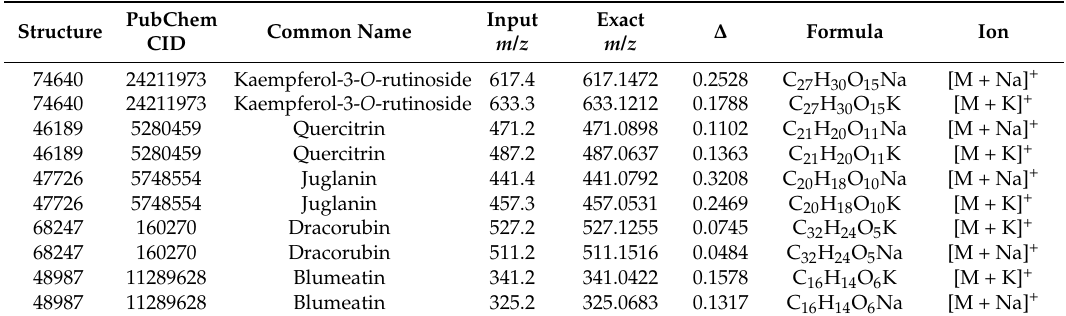
Table 1. Mass spectrometric analysis of the Wild garlic ( Allium ursinum ) samples. Table 1 shows measured and exact m / z values of the main compounds present in A. ursinum leaf liophylisate.